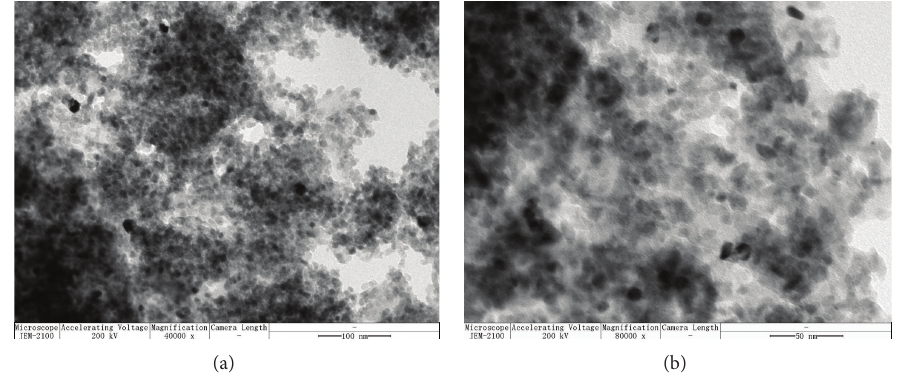
Figure 3: TEM images of the prepared TiSn10 nanoparticles.